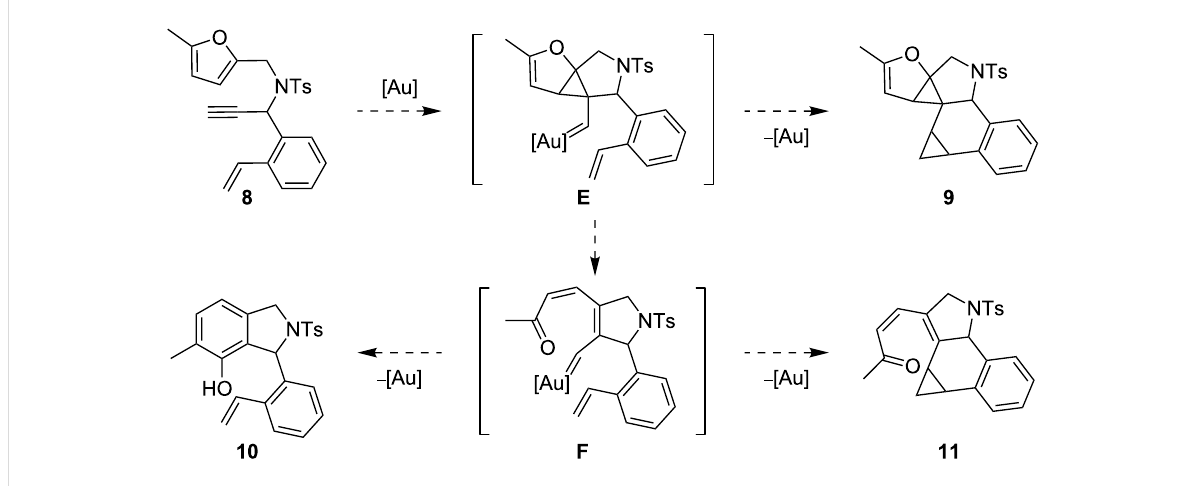
Scheme 4: Potential products of an intramolecular trapping experiment with substrate 8 .